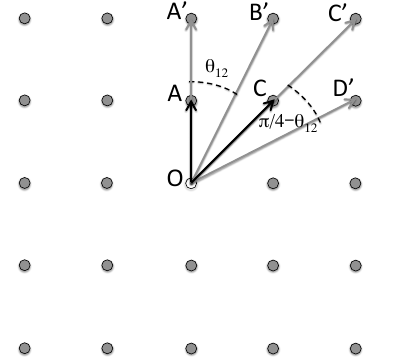
Table 2. Parameters of the graph for the Mediterranean Sea after the removal of nodes and edges on the landmass (GSHHG coastline used). In the actual route computations, just a subdomain of the whole basin is selected. Due to border effects, the connectivity ratio A/N < 24 (value that would be expected from Fig.